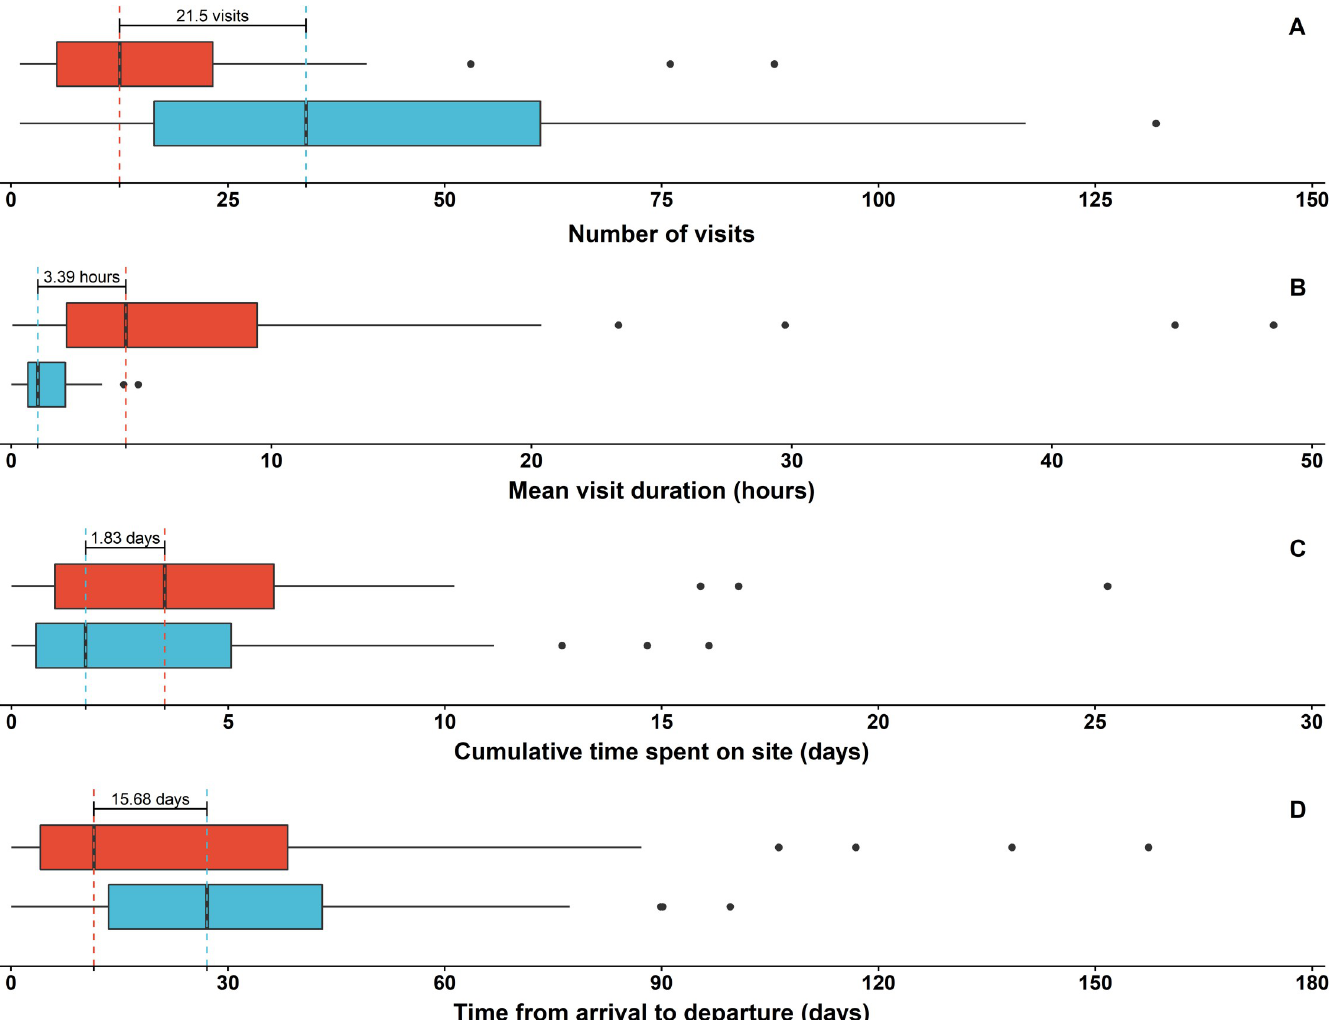
Fig 8. Nurse shark residence in the Dry Tortugas courtship and mating ground during mating season (June-July). Data based on acoustic detections of females (red) and males (blue), respectively. a) the mean number of visits to the site during mating seasons; b) mean visit duration (hours) for sharks during the mating season; c) the cumulative time (days) individual sharks were detected on site during mating seasons; and d) time from arrival to departure from the site during the mating season. A visit was defined as a sequence of acoustic detections without a gap of 60 minutes or more. Dashed lines indicate the median value for each metric, by sex, with the difference between the medians denoted with